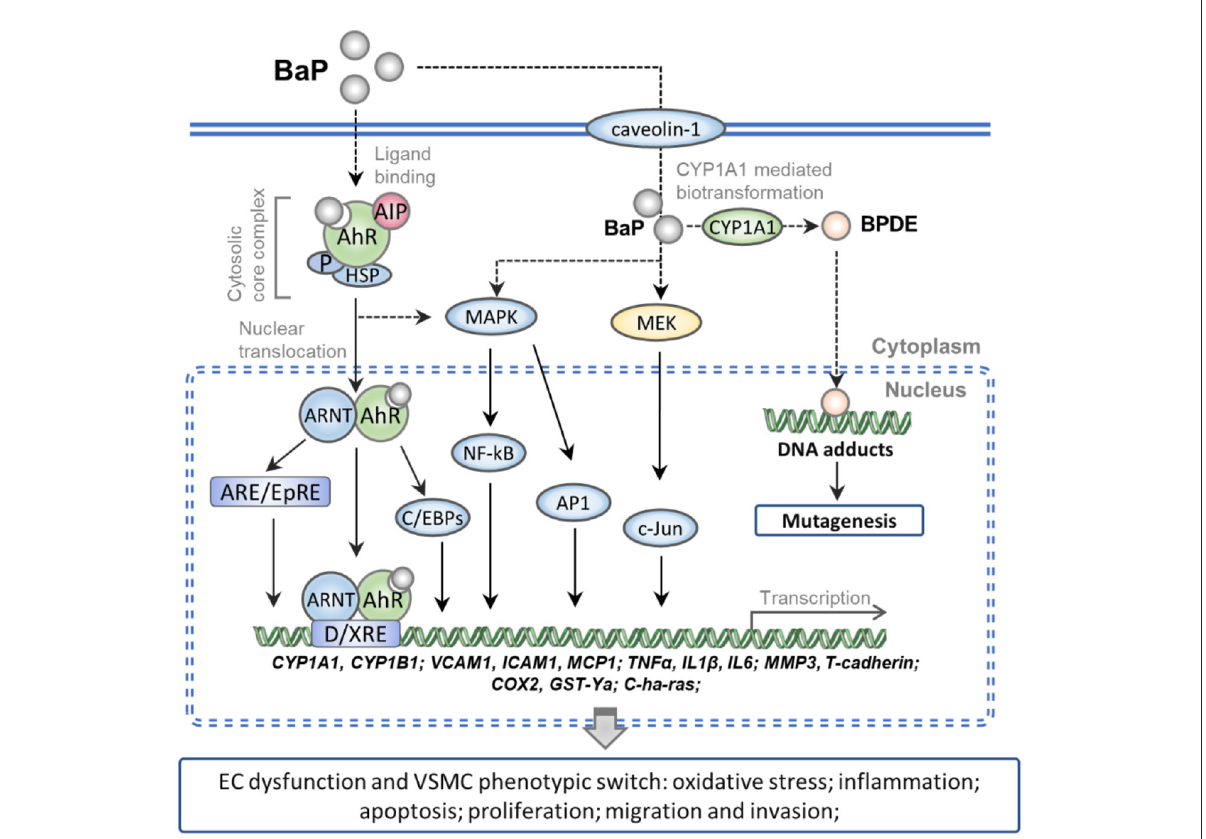
FIGURE1 Schematic representation of the molecular mechanism of BaP exposure-induced CVDs. Numerous pieces of evidence show that the caveolin-1 can facilitate entry of the BaP into vessel-wall cells. The AhR complex is translocated into nuclear after binding with intracellular BaP. And then the BaP-AhR complex could activate the AhR/ARNT/XRE, MEK/c-Jun, and MAPK/NF-kB/AP-1 signaling pathway which can up-regulate the gene of CYPs, cell adhesion molecules, pro-inflammatory factors, and peroxidase. Besides, the activated CYP1A1 actually increased the metabolism of BaP into BPDE, which can form DNA adducts and induce mutation. As a result, BaP exposure increases the ECs dysfunction and VSMC phenotypic switch which accelerates the pathological progress of